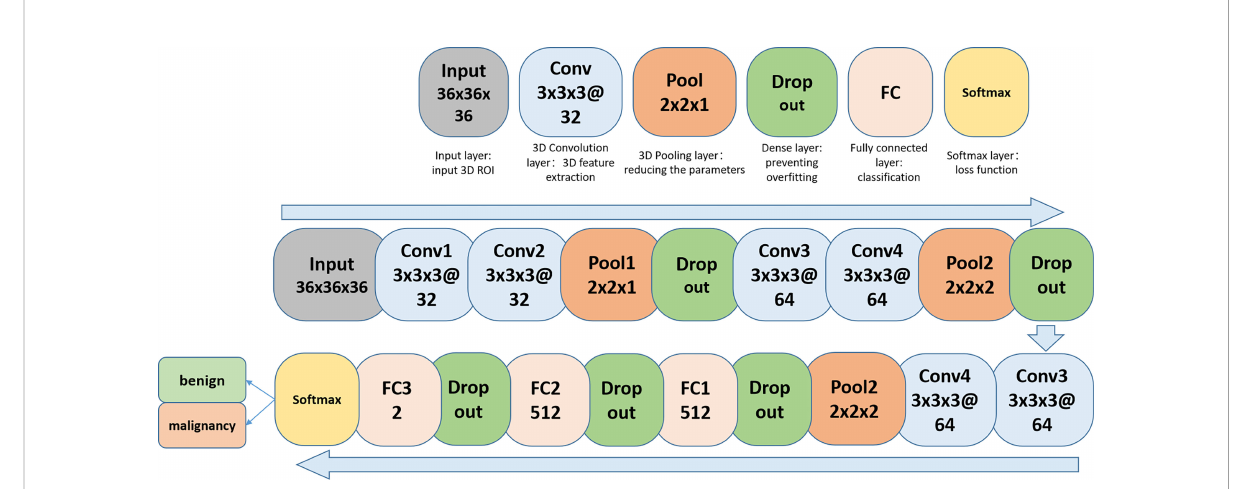
FIGURE 5 The network architecture of CNN for prediction of benign and malignant breast